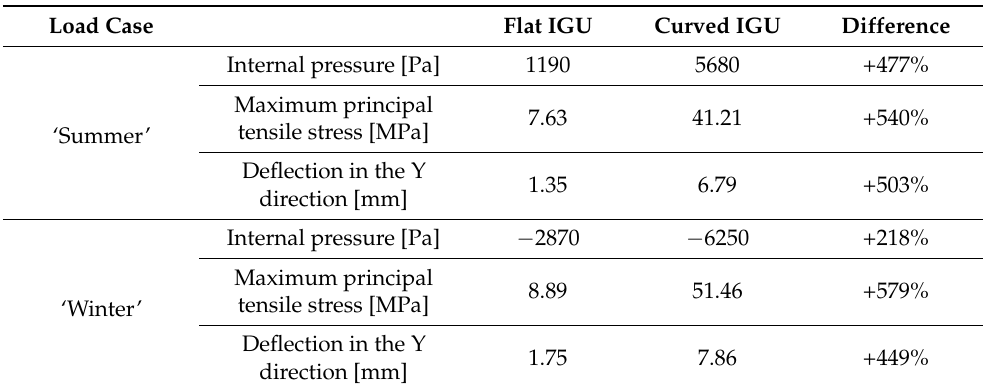
Table 3. Results of the case study.